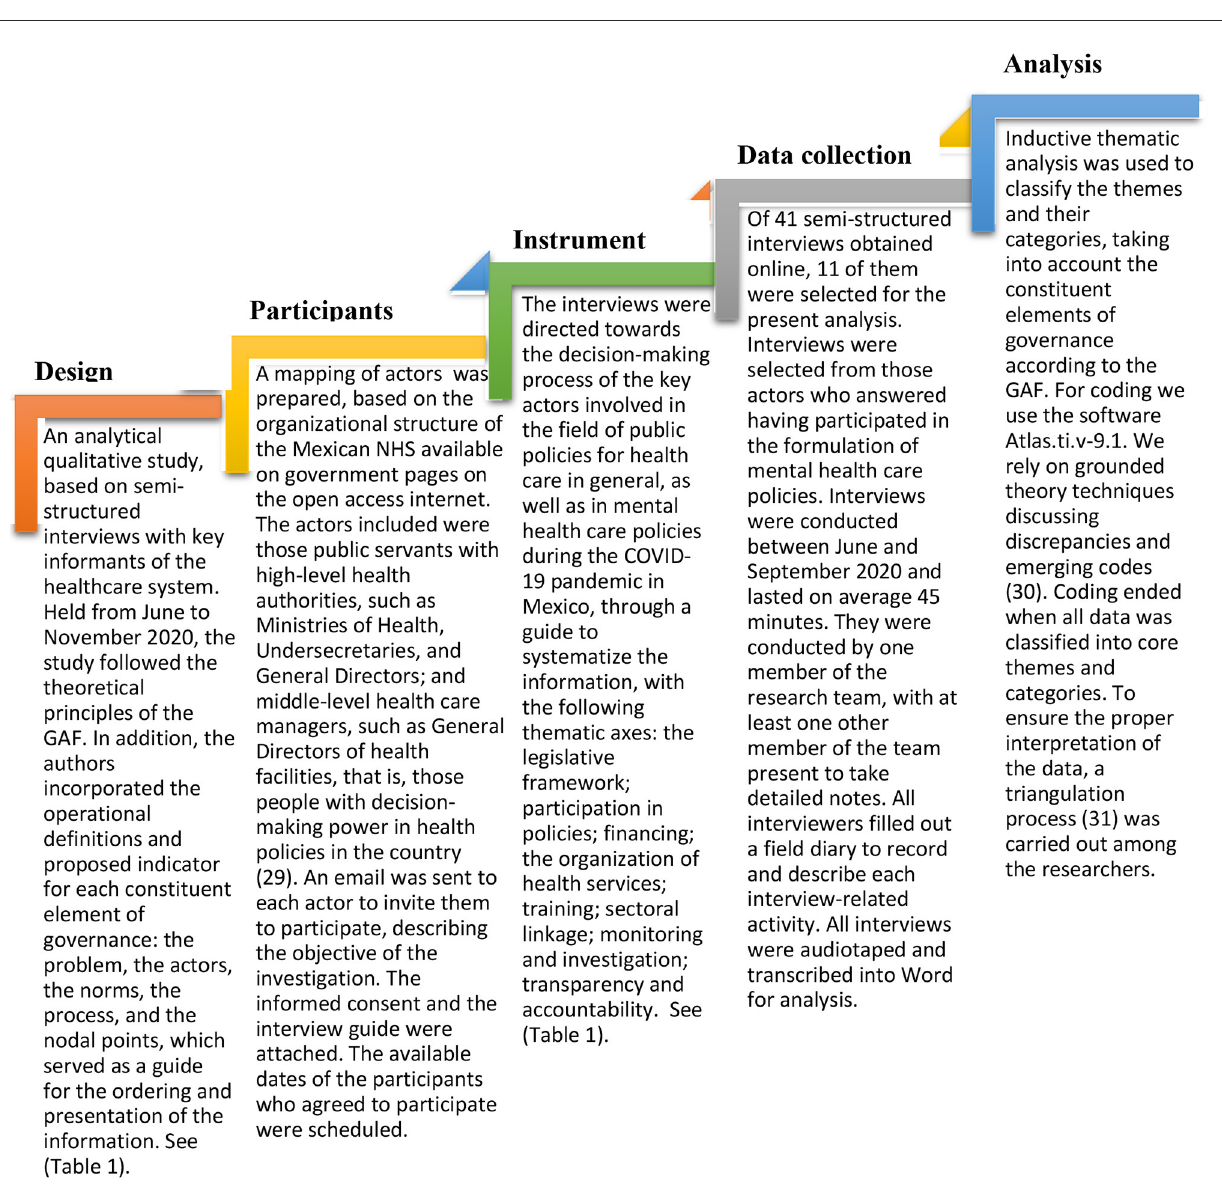
FIGURE1 Applied research